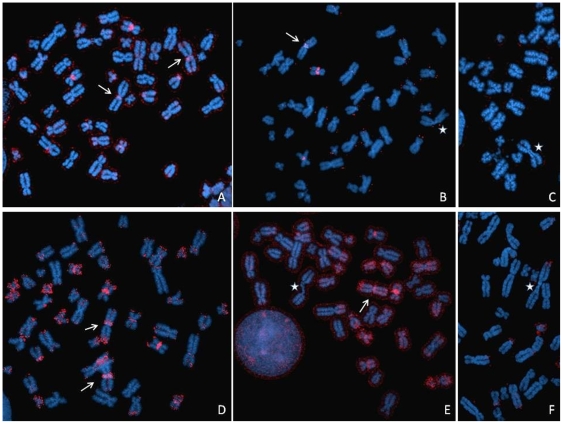
Changes in chromosomal methylation patterns upon treatment with 5-azacytidine.Control cells were treated with the demethylating agent 5-azacytidine and subsequently immunostained with a monoclonal antibody against 5-Methylcytidine (red signal). A significant variability in terms of extent and distribution of DNA methylation within the cell populations (Control 1: A, B and C; Control 2: D, E and F) was observed, with some metaphases and nuclei showing almost no methylation at all and others showing still substantial methylation, particularly on the compact heterochromatic areas (white arrows). However, stretched or decondensed heterochromatin in metaphase appeared to be consistently demethylated (white stars). Arrows and stars point specifically to chromosome 1 juxtacentromeric heterochromatin.